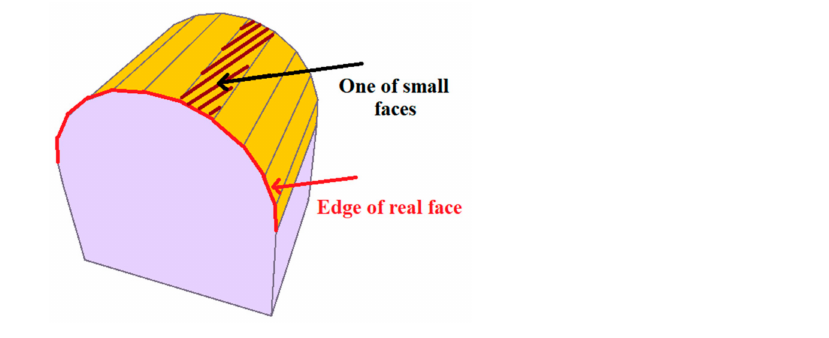
Figure 2. After extracting faces of legal space, a complex roof will be associated with several small faces of legal